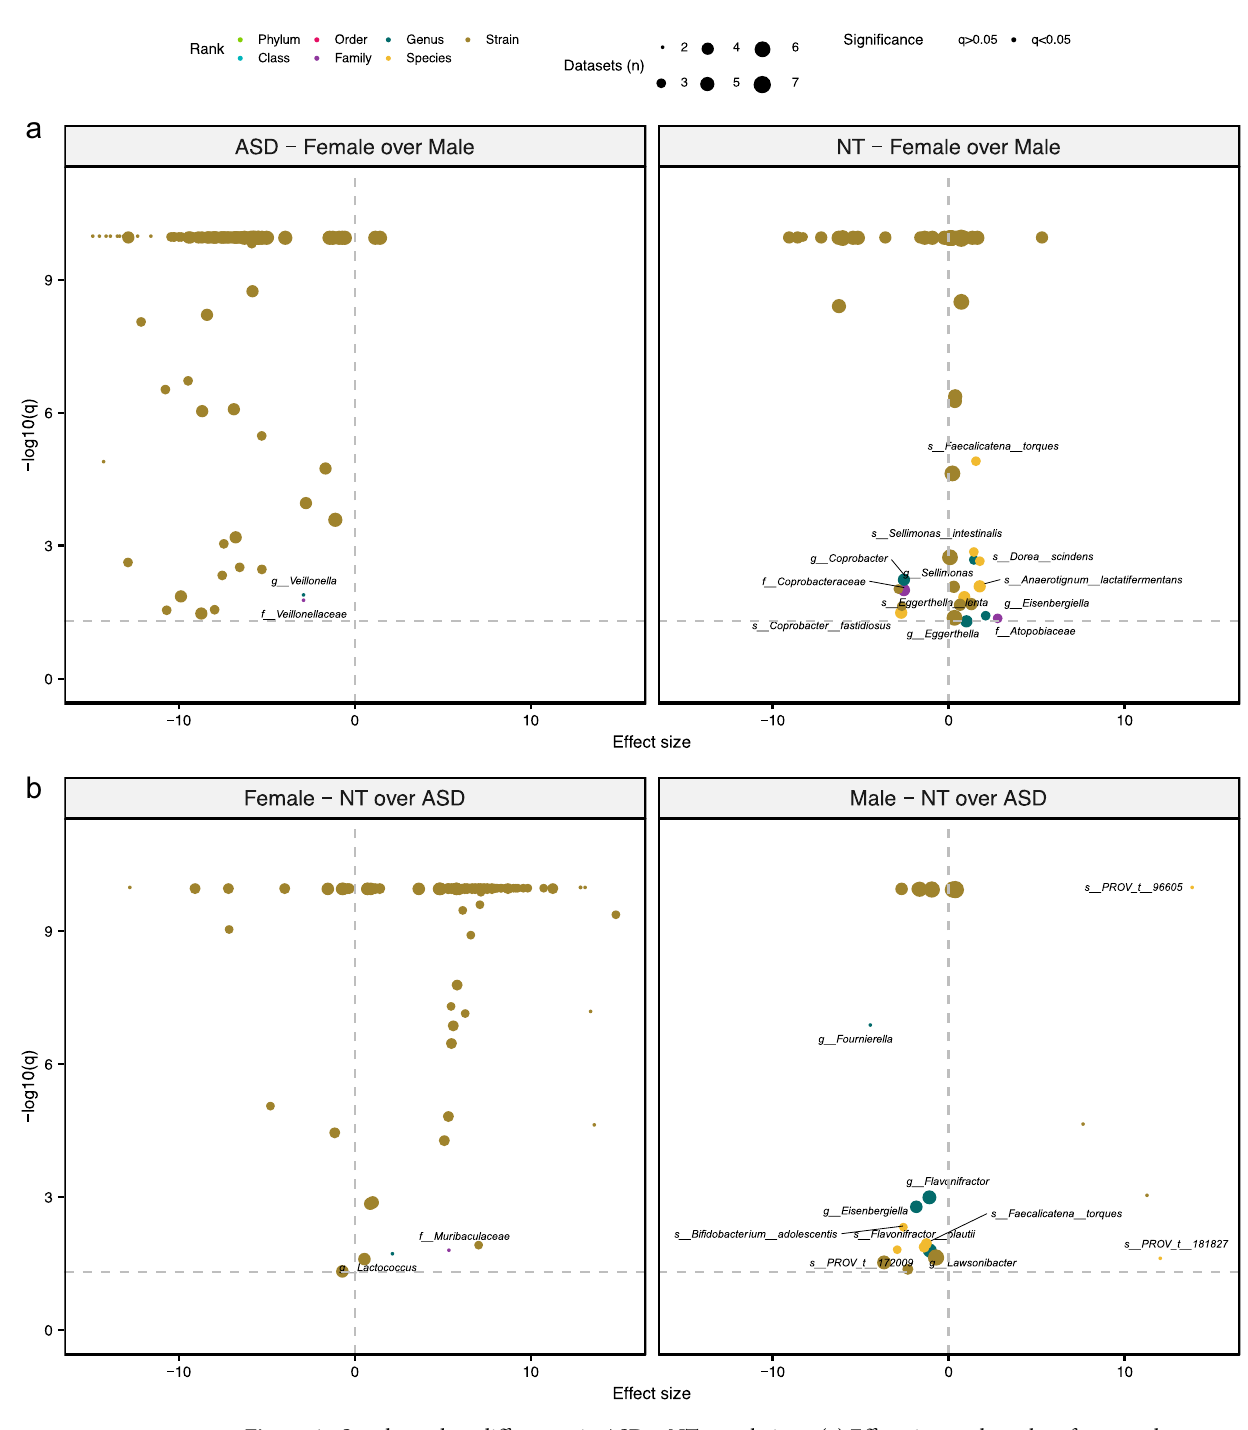
Figure 6. Sex-dependent differences in ASD v. NT populations. ( a ) Effect sizes and q -values from random- effects models investigating the associations between different taxa and sex (female: positive direction, male: negative direction) in the ASD compared to NT groups are plotted. ( b ) Models investigating ASD-associated taxa (NT: positive direction, ASD: negative direction) in either males or females are also plotted. The color, transparency, and size of each point denotes the taxonomic rank of the taxon, the significance of the model, and the number of datasets included in the model, respectively. Horizontal dotted line indicates significance threshold (q = 0.05). Significant models are labelled by the taxon investigated except for strain-level results. These models are reported in Supplementary file 1: Table